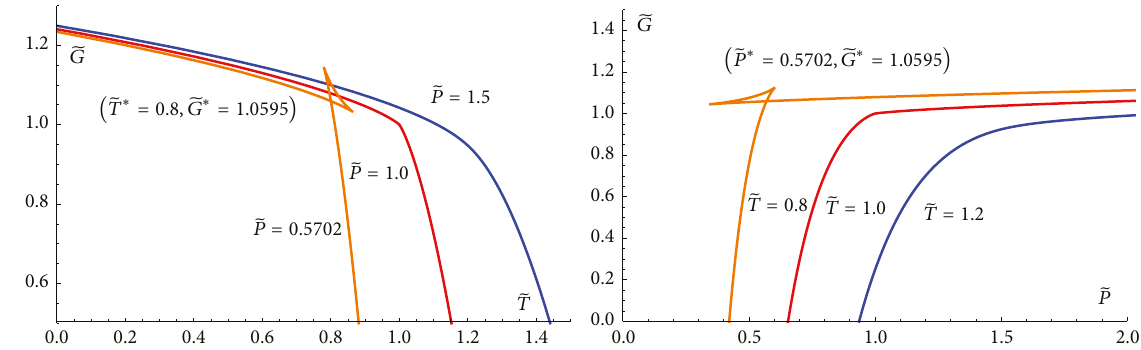
̃𝑇 ̃𝐺 ̃𝑃 = 0.5702,1.0,1.5 ̃𝑃 ≤ 1.0 vs. for different . When , there is var der Waals system’s swallow tail behavior, and ̃𝑇 = 0.8,1.0, 1.2 ̃𝑇 ≤ 1.0 ̃𝐺 ̃𝑃 vs. for different . When , there is also var der Waals